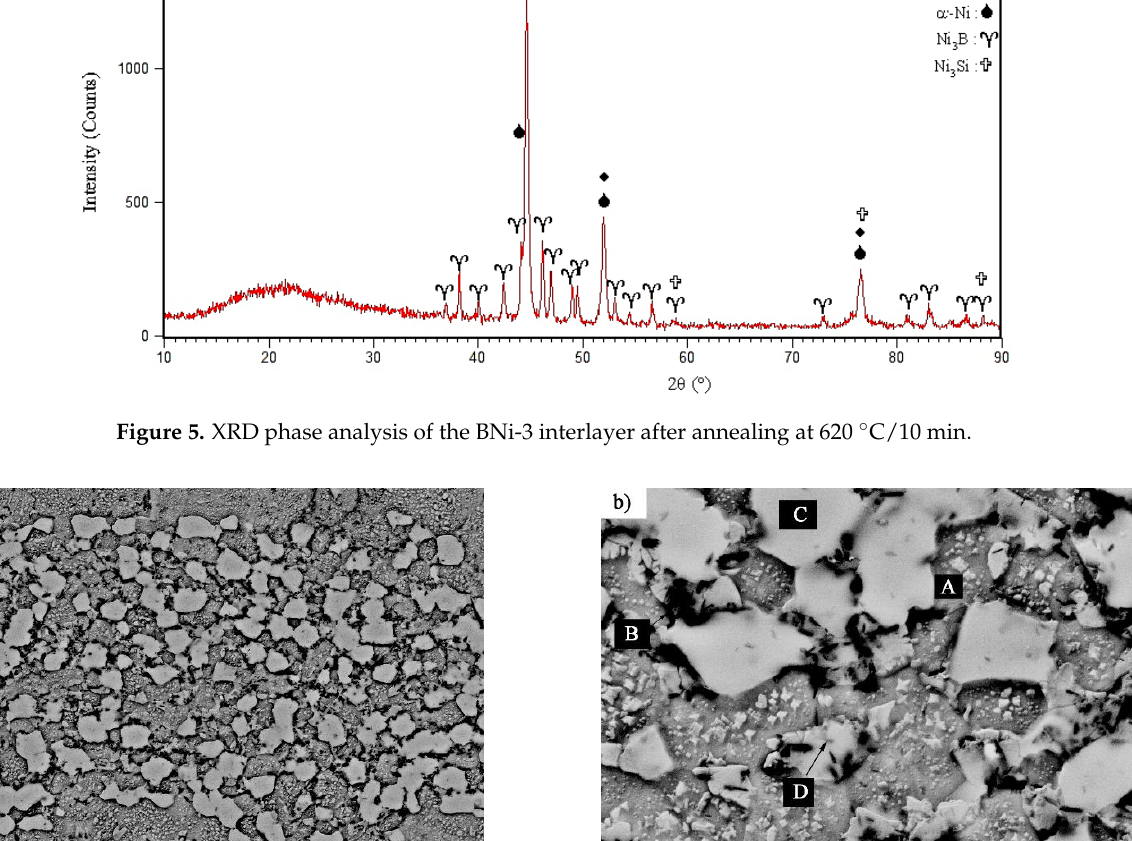
Table 3. The energy dispersive X-ray ( EDX ) analysis of the various phases indicated in Figure 6 (wt.%).